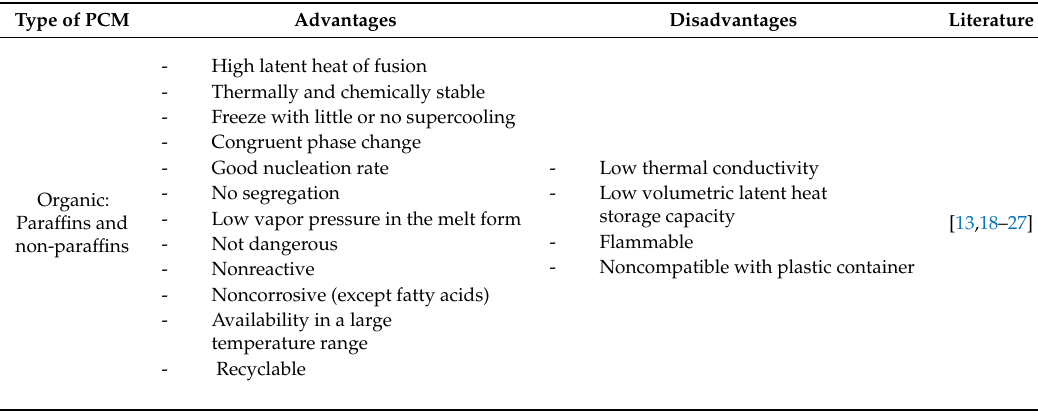
Table 1. Advantages and disadvantages of different types of